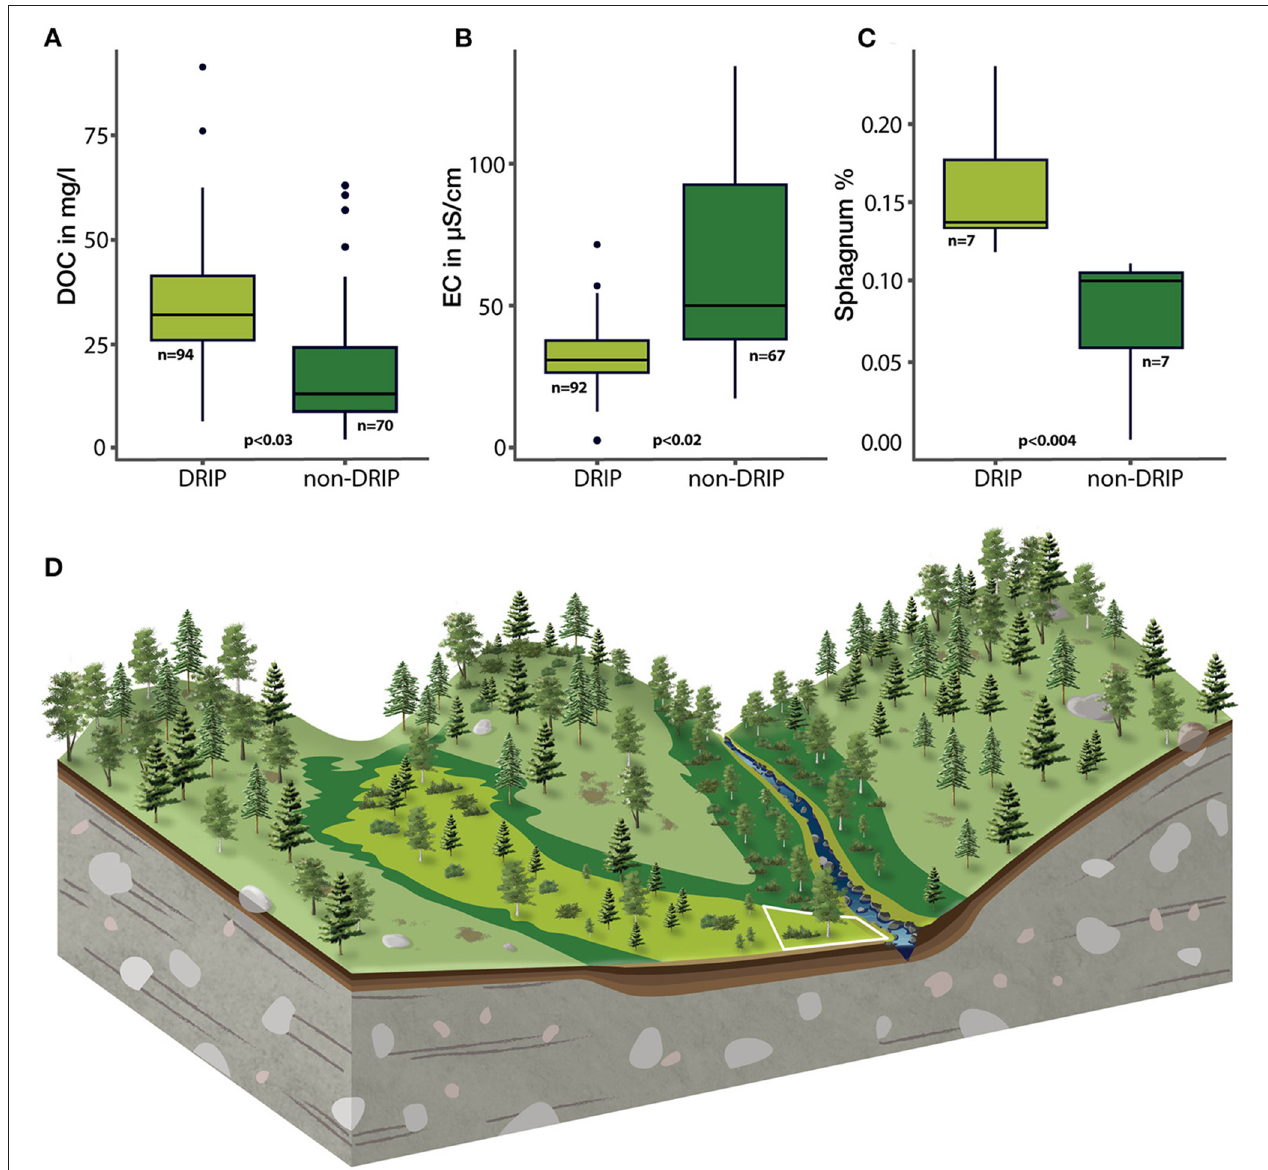
FIGURE 2 | DRIP and non-DRIP characteristics. (A) shows boxplots of the DOC concentrations of groundwater, collected in DRIP (light green) and non-DRIP wells (dark green). The number of observations per group ( n ) are provided and p -values are based on well averages (10 DRIP wells and 10 non-DRIP wells) using a T -test where p -values < 0.05 were considered significant. (B) shows in a similar way the EC of groundwater in DRIPs and non-DRIPs. (C) shows the abundance of Sphagnum moss (as a % from all bryophyte species found at each site) across DRIPs and non-DRIPs. (D) is an illustration of a DRIP (white box) positioned along a forest headwater